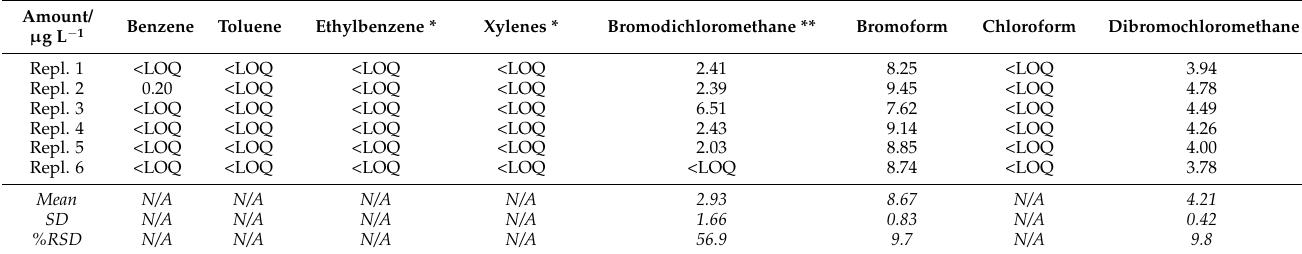
Table 8. Measured concentrations (in µ g L − 1 ) in drinking water (Cambridge, UK) samples for BTEX and THMs. The mean, standard deviation (SD), and RSD (%) are also